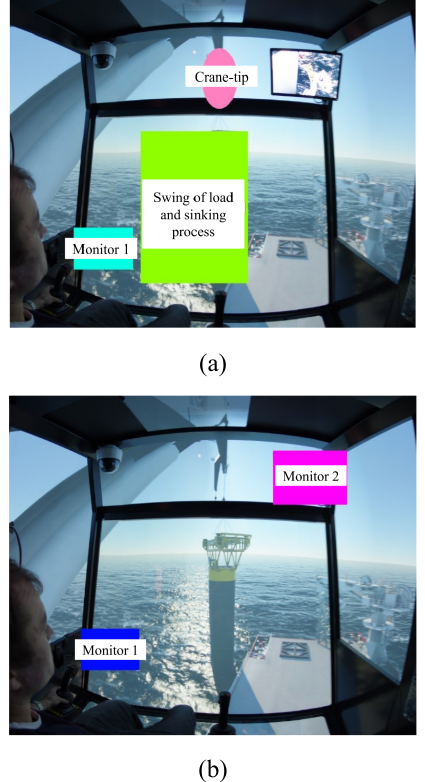
Figure 3: Target stage two: load descending to seabed and back to water surface.